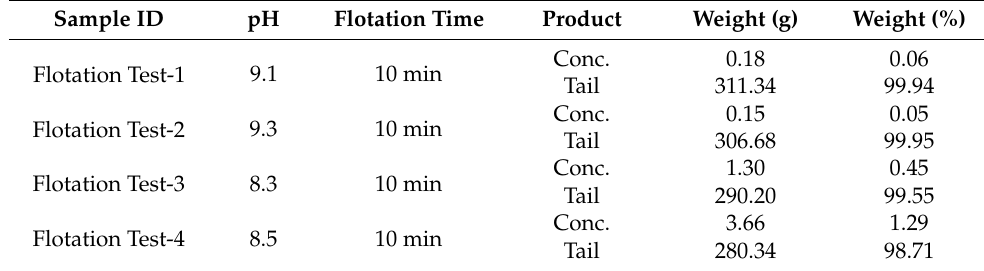
Table 3. Flotation test conditions and results summary.